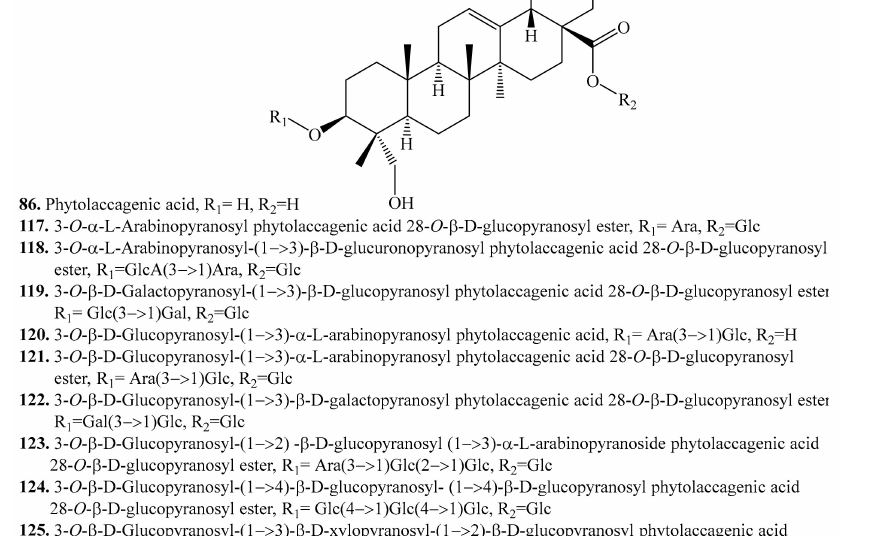
Figure 15. Structures of phytolacagenic acid and its glycosides isolated from quinoa.